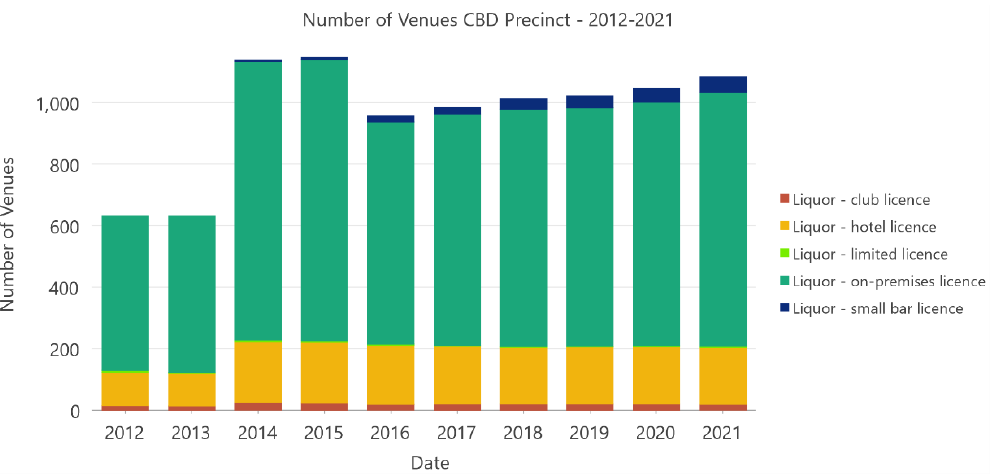
Figure 21. Number of venues by type 2012–2021 in CBD precinct.